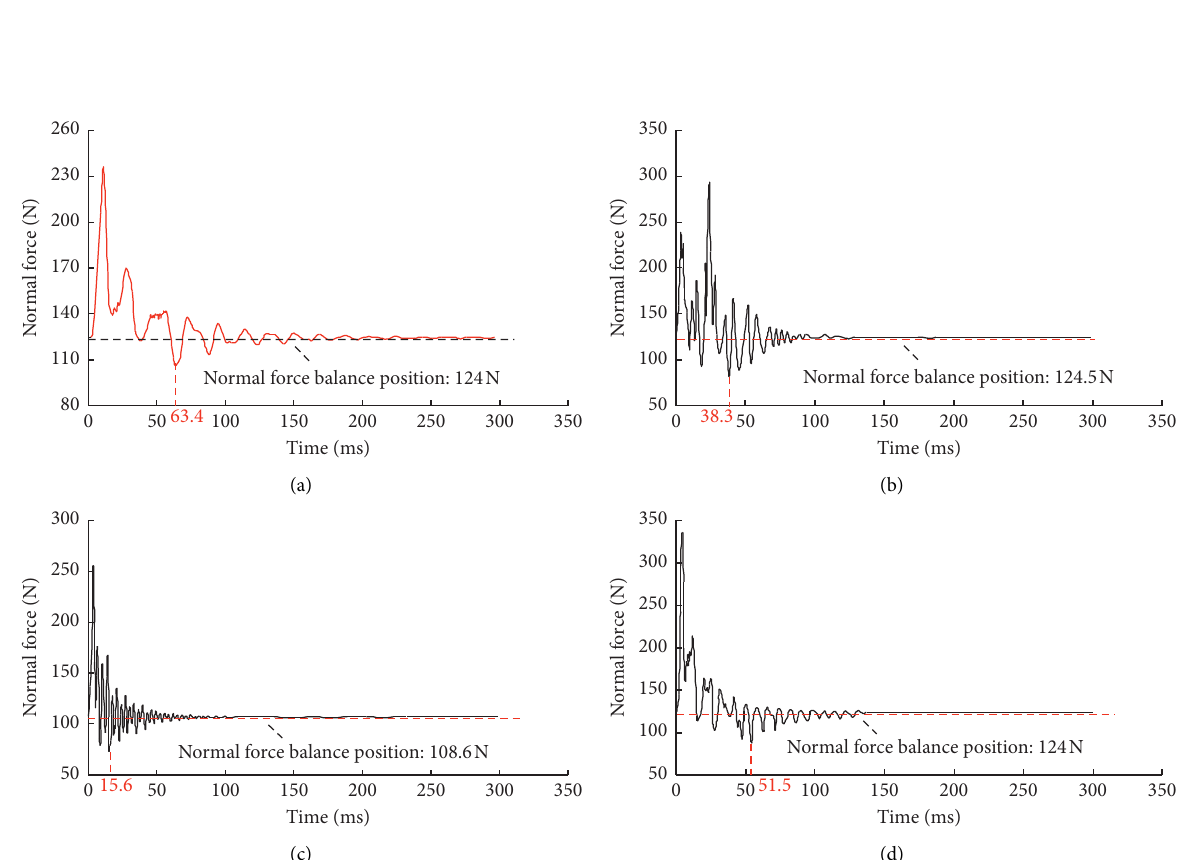
Figure 16: Time history curve of the normal force on the contact surface under different lithology. (a) Single lithology: all blocks are sandstone. (b) Combination 1: mudstone+sandstone +sandstone. (c) Combination 2: sandstone +coal+sandstone. (d) Combination 3: sandstone+sandstone